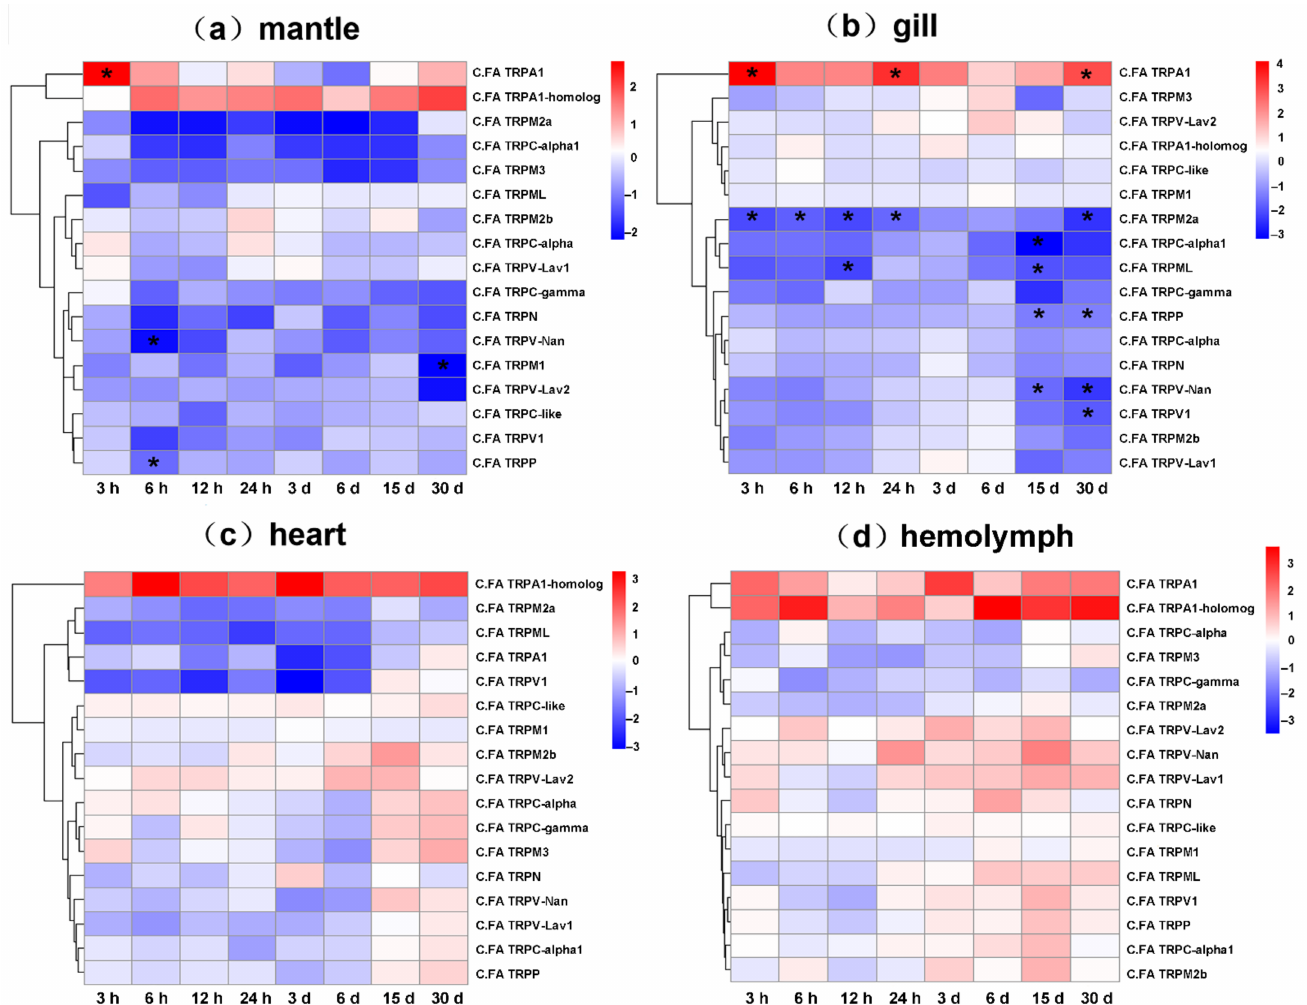
Figure 6. Heatmaps of C.FA TRP genes expression under high temperature stress along different time points in mantle ( a ), gill ( b ), heart ( c ) and hemolymph ( d ). The heatmaps were drawn based on log 2 FC values. * indicates significant difference (|log 2 FC| > 1 and p <